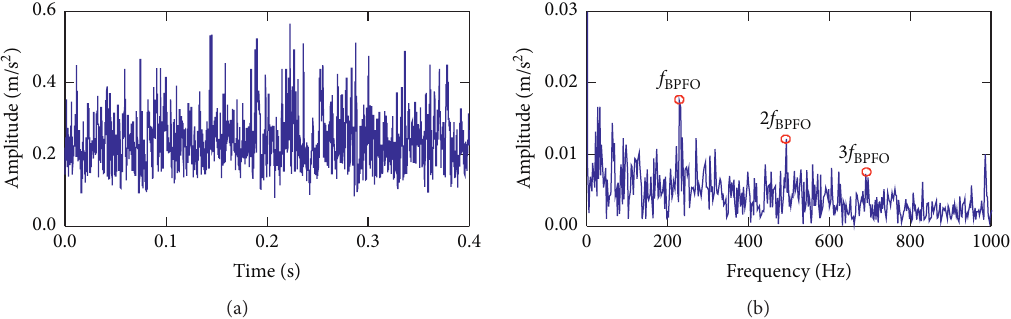
Figure 29: Analysis results of experimental signals by the ACDIF method: (a) time-domain spectrum; (b) envelope spectrum.